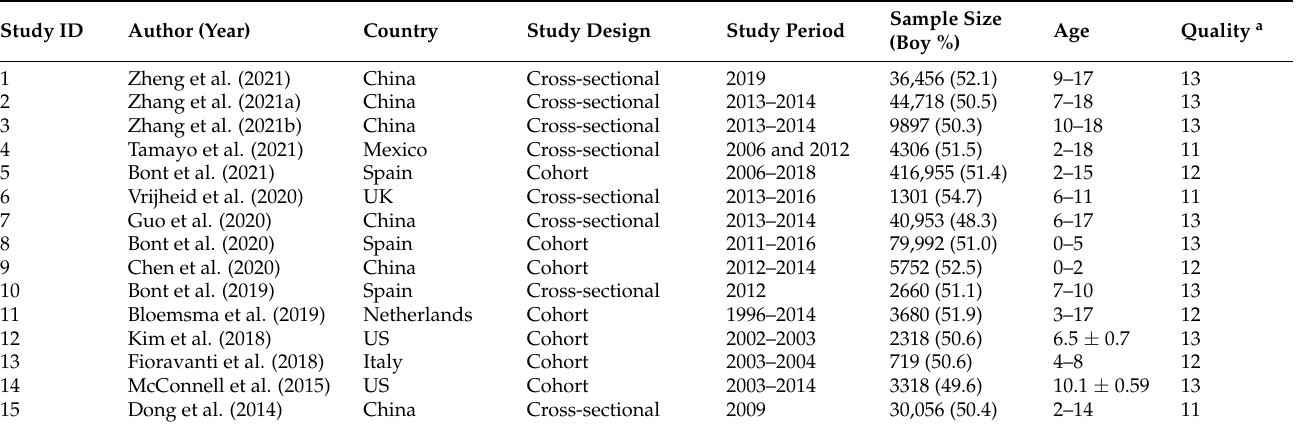
Table 1. Characteristics of the 15 included studies on the association between air pollution and childhood